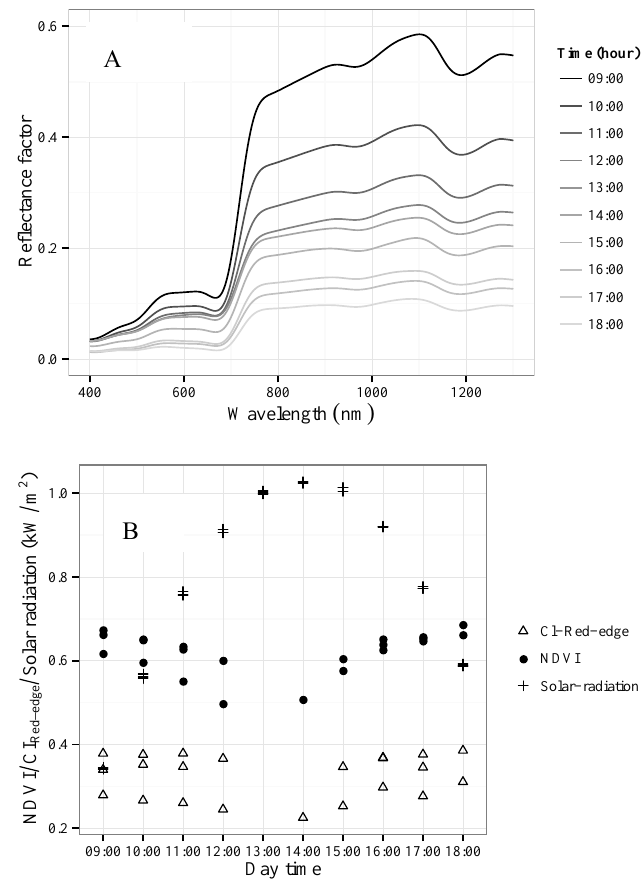
Figure 12. ( A ) Hourly changes on Tamarugo canopy spectral signature measured on 13 January 2012 (summer). ( B ) Hourly values of NDVI and CI Tamarugo trees and solar radiation measured on three consecutive days: 13–15 January